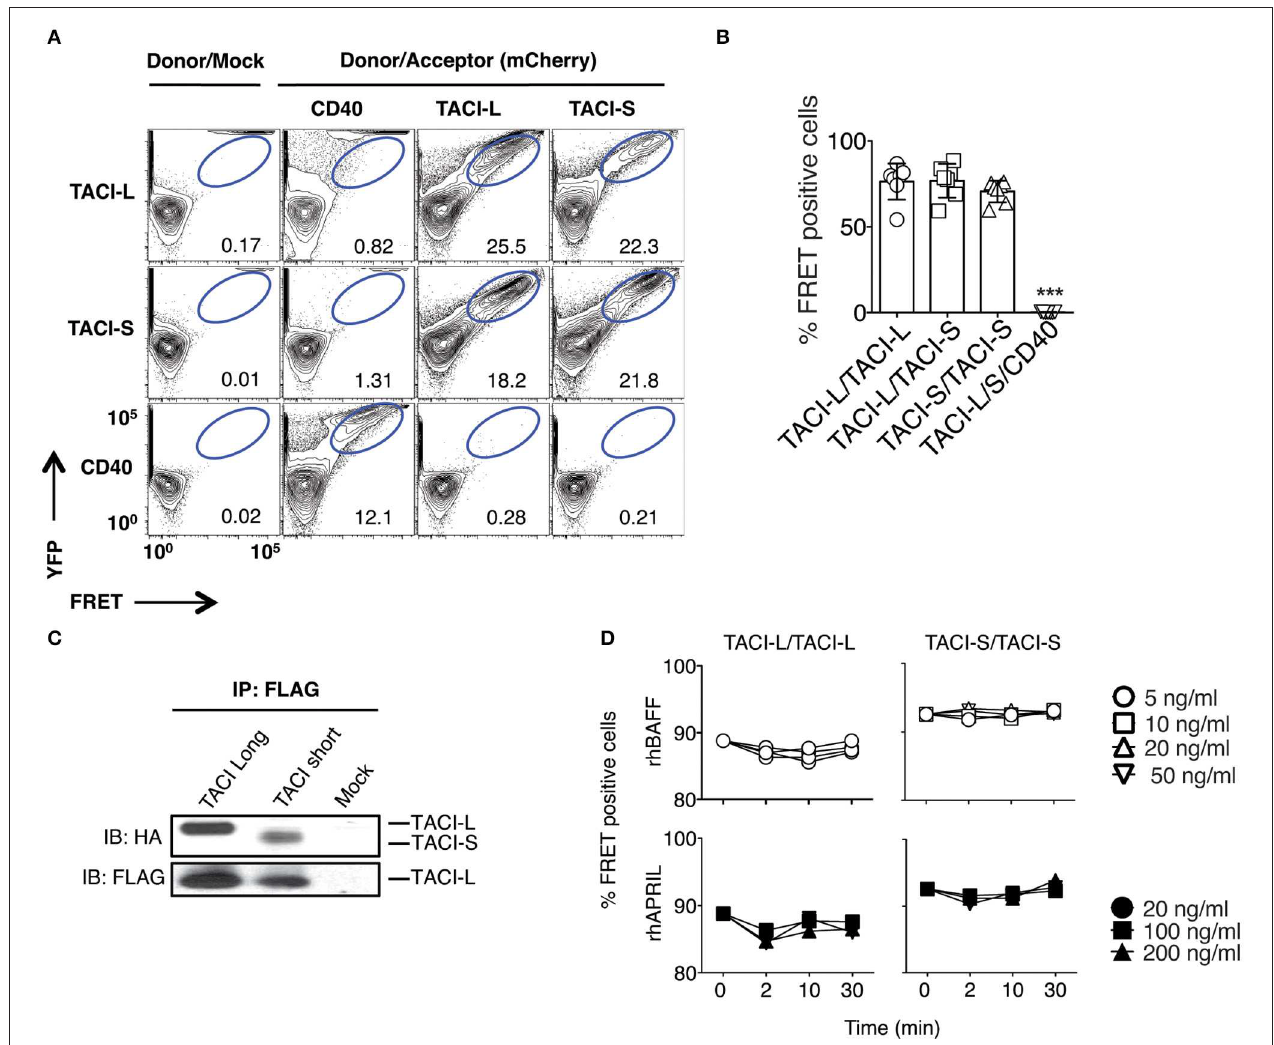
FIGURE 1 | TACI Isoforms form hybrid complexes detected by FRET. (A) To examine isoform complexes, YFP and mCherry labeled TACI-L, TACI-S, and/or CD40-eYFP as a control, were co-transfected into HEK-293T cells. After 48h, the molecular association was analyzed by FRET using FACS (LSRII). A minimum of 50,000 positive cells were examined in all experiments. The dot plot results in each panel, are shown for one sample, representative of the results for 6 different experiments. The numerical data given in each panel, are the percent of FRET positive cells, of the live cells in the gate, averaged for all 6 experiments. (B) Frequency of FRET positive cells in the double positive YFP and mCherry gate from (A) . Graph shows the mean ± SD. *** p < 0.001, two-tailed paired Student t -test of 6 independent experiments. (C) Either HA-labeled TACI-S or TACI-L transfected into HEK-293T cells, could be precipitated with TACI-L-FLAG as demonstrated in immuno-blotting using anti-HA staining. Lower panel shows FLAG expression as control. (D) Addition of increasing amounts of ligands BAFF or APRIL to the TACI-S and TACI-L complexes had no effect on the FRET signal, indicating that receptor assembly in these cells is ligand independent. Data are the mean ± SD from 3 independent